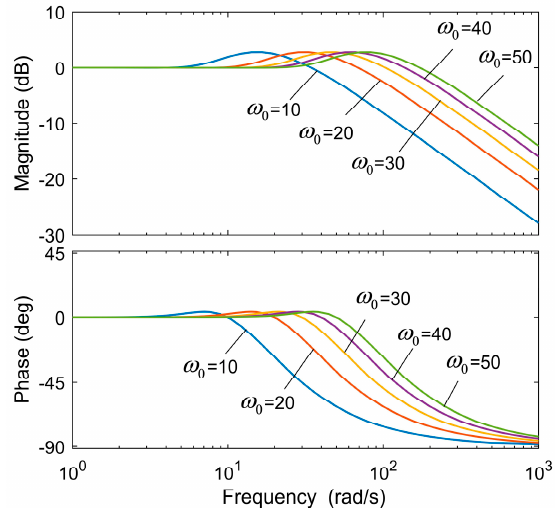
Figure 8. Frequency-domain characteristic curve of observed noise.